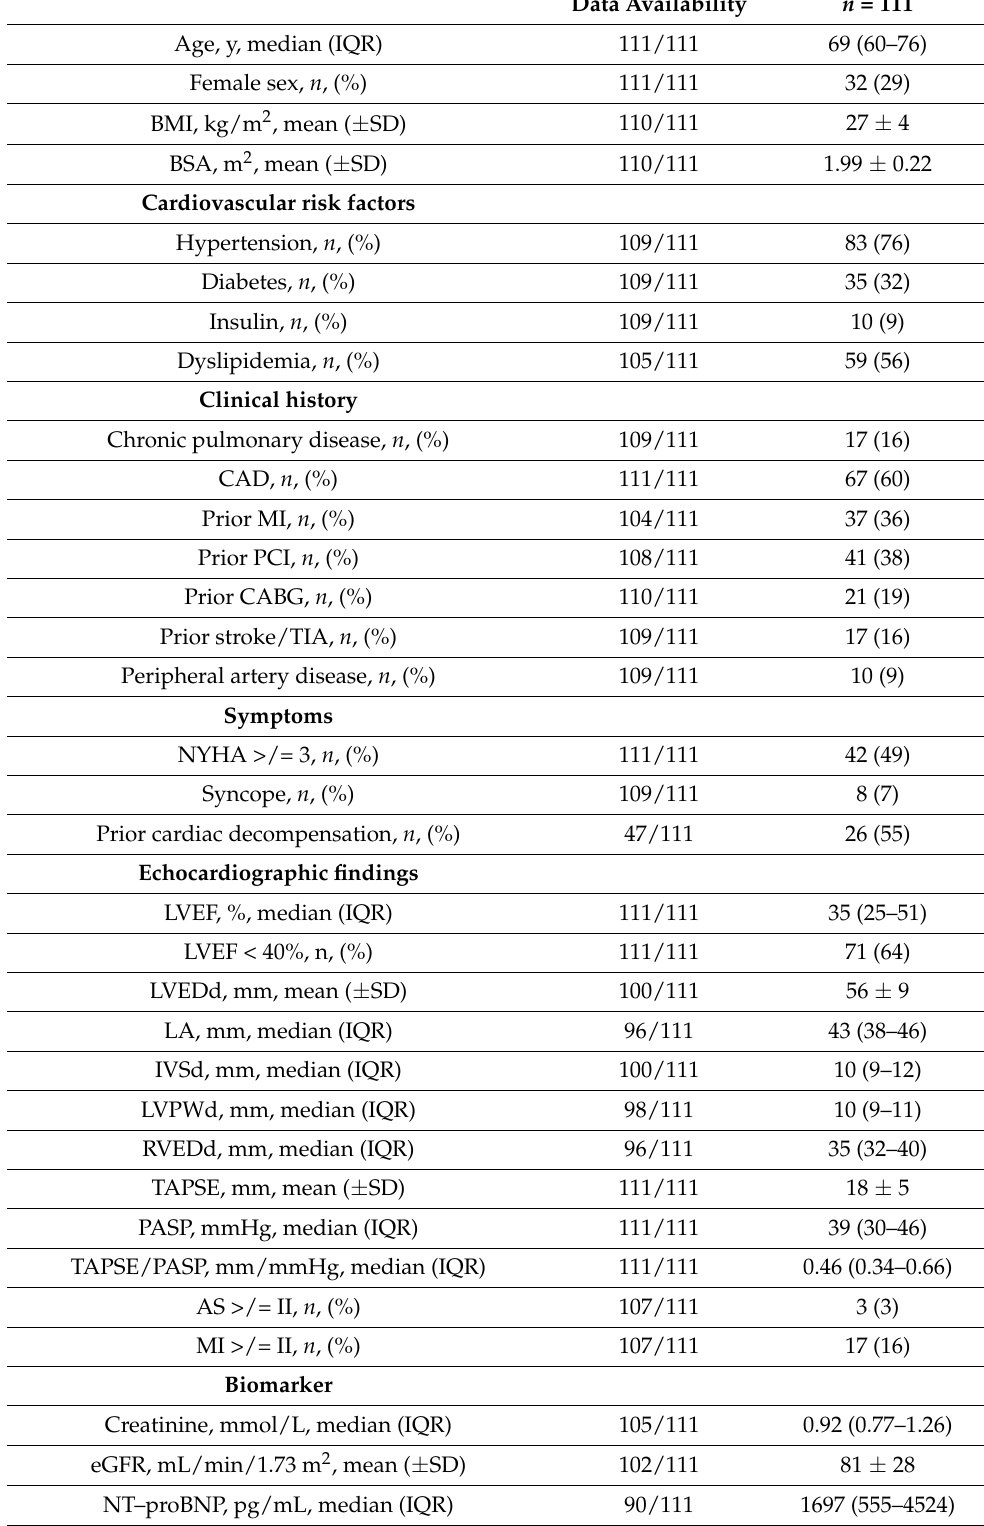
Table 1. Clinical characteristics of the imaging